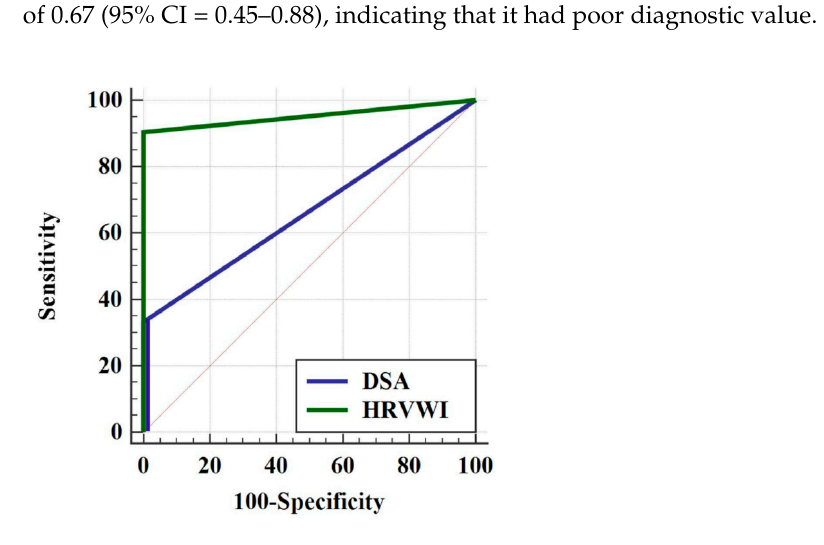
Figure 4. ROC curve for high-resolution vessel wall imaging (HR-VWI) and digital subtraction angiog- raphy (DSA). The area under the receiver operating characteristic curve is 0.95 (95% CI = 0.87–1.00) for HR-VWI and 0.67 (95% CI = 0.45–0.88) for DSA. (CI; confidence